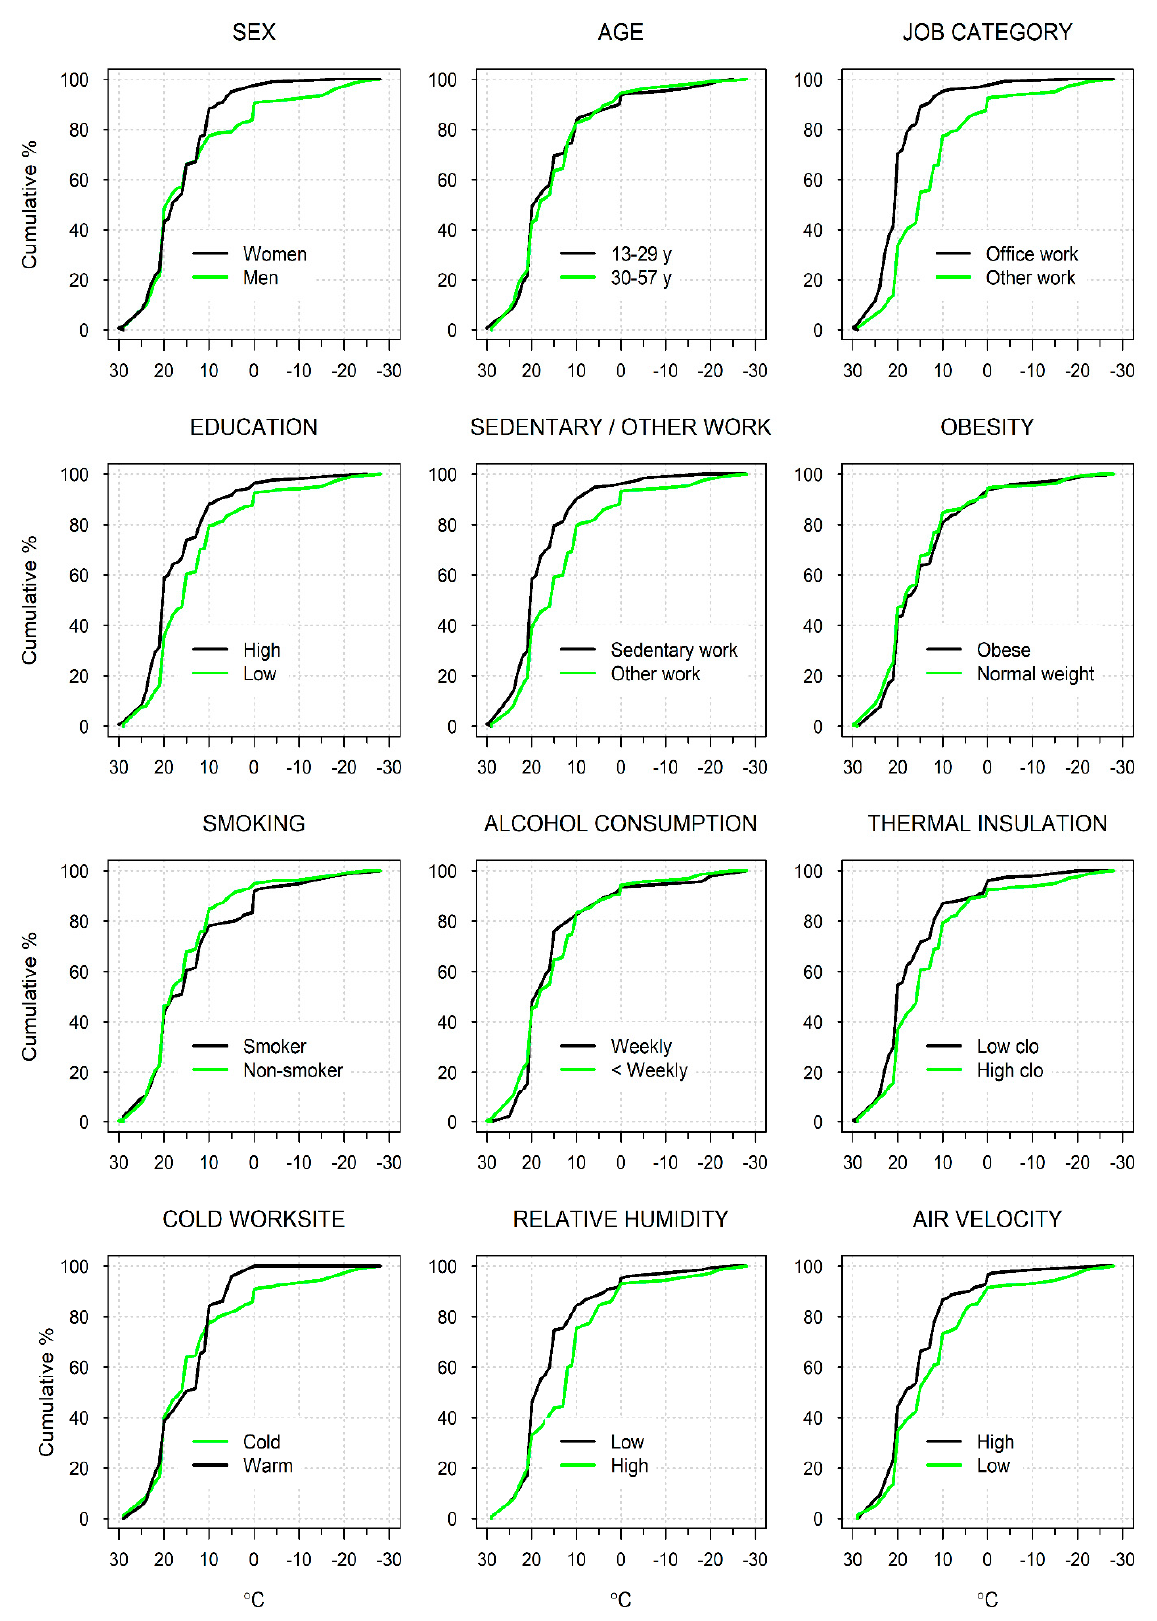
Figure 2. Cumulative distributions of self-assessed threshold for cold temperature (°C) according to personal and workplace characteristics and physical conditions at workplace.